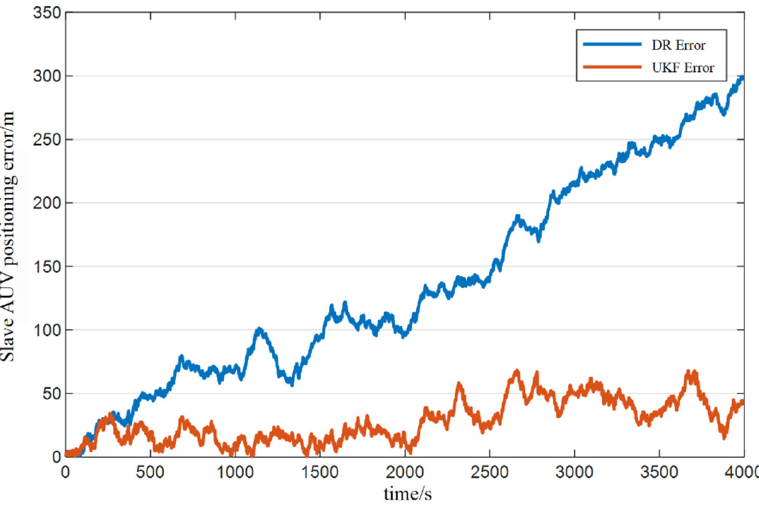
Figure 20. Positioning error of the slave AUV based on UKF.